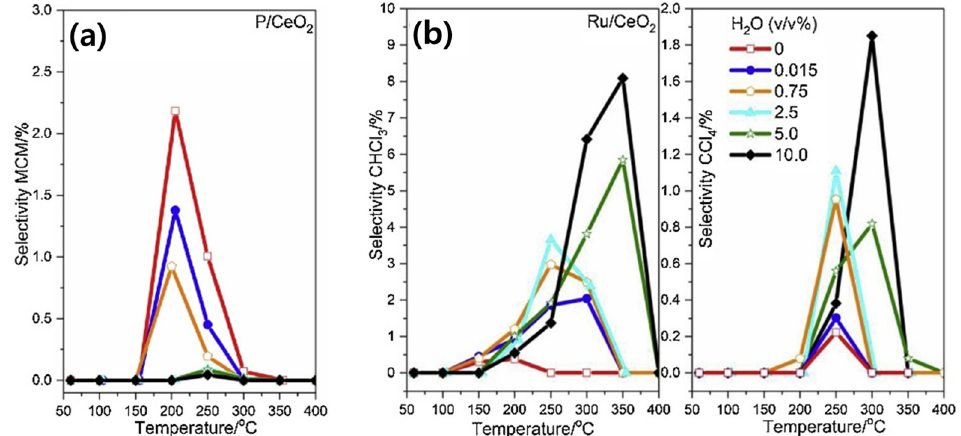
Figure 4. ( a , b ) Deactivation effect of catalysts by H 2 O in CVOC oxidation by analyzing by-products using P/CeO 2 and Ru/CeO 2 . Reprinted with permission from ref. [106]. Copyright 2019 Elsevier.